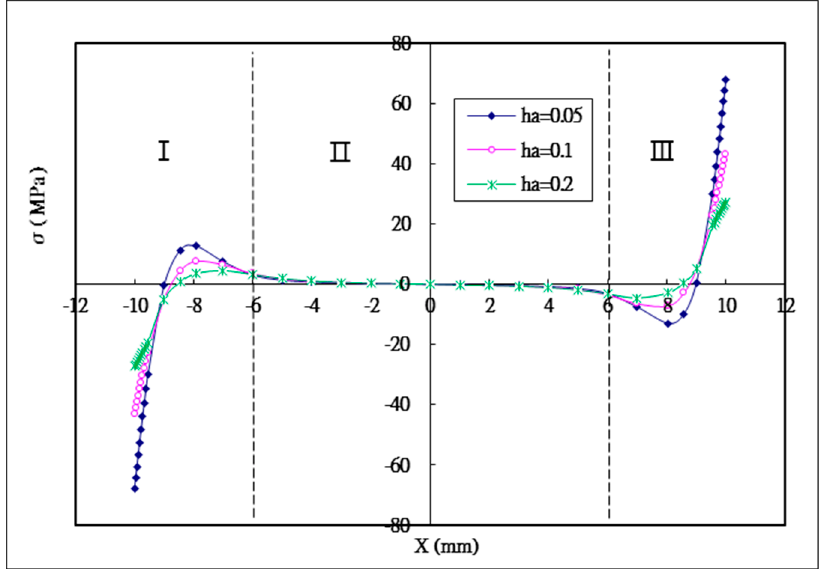
Figure 8. Peel stress distribution in the adhesive with three different adhesive thicknesses.